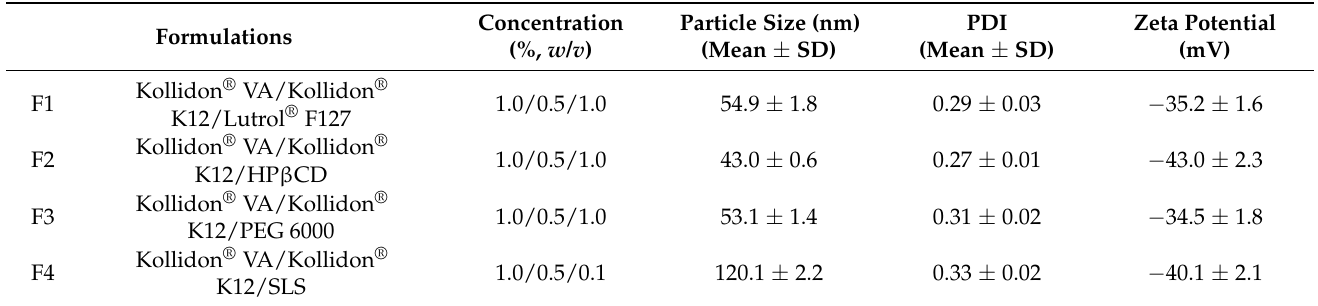
Table 5. Particle size, polydispersity index (PDI), and zeta potential of optimized nanosuspensions stabilized in the mixture of Kollidon ® VA and Kollidon ® K12 along with one of Lutrol ® F127, hydroxypropyl β -cyclodextrin (HP β CD), polyethylene glycol (PEG) 6000 or sodium lauryl sulfate